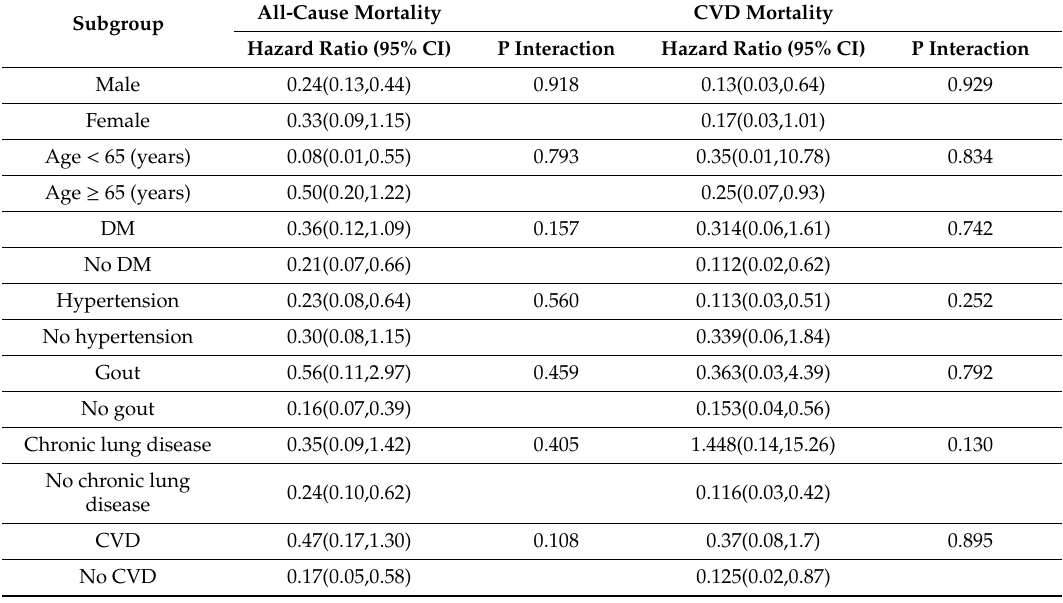
Adjusted associations of AGR with risk of all-cause and CVD mortality in pre-specified